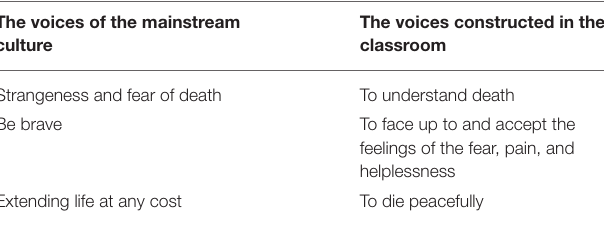
TABLE 2 | The collision between the classroom voices and the voices of the mainstream culture. The voices of the mainstream